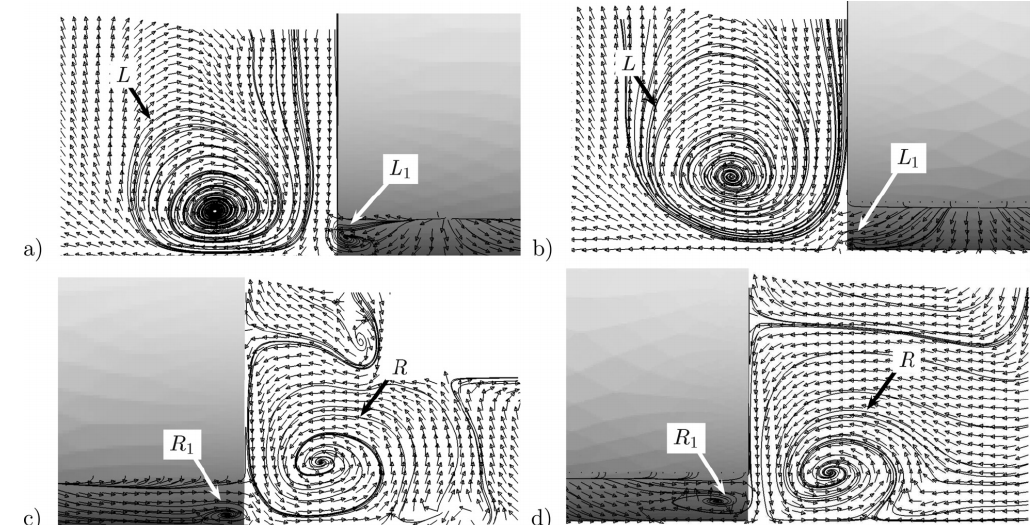
Figure 9. Velocity vectors and streamlines in plane x = 20 mm behind the wheel centre. ( a , b ) Outside the wheelhouse. ( c , d ) Inside the wheelhouse by Krajnovic